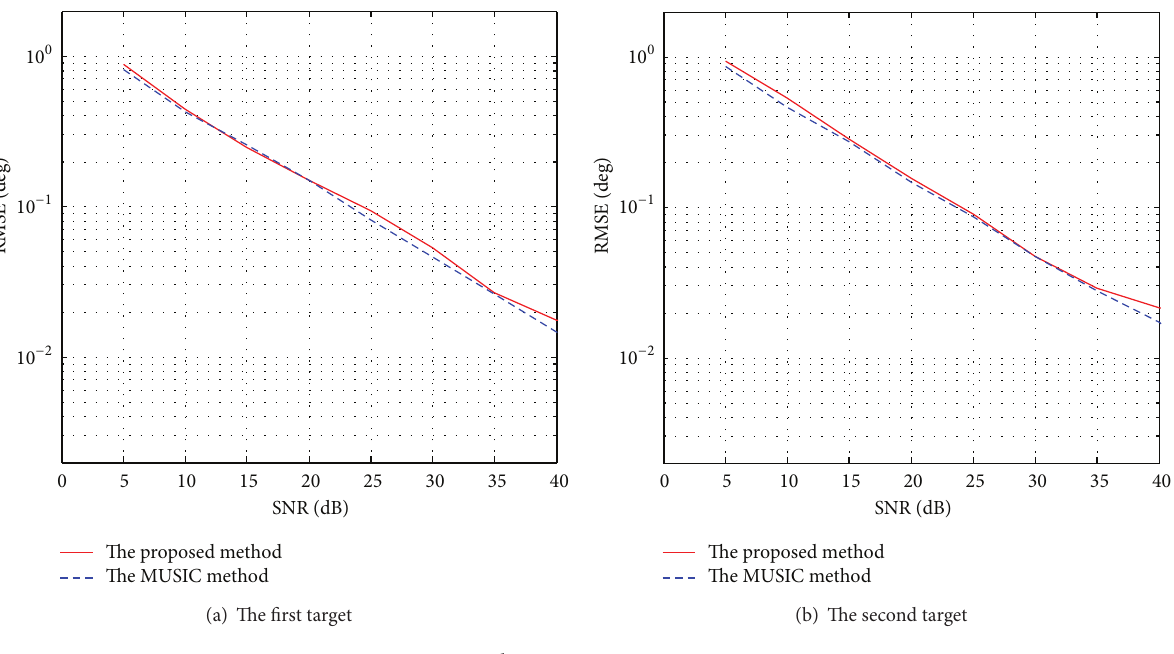
Figure 2: RMSE in DOA and DOD estimation versus SNR.